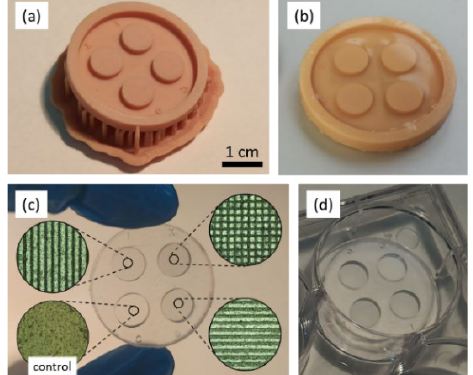
Fig. 1. Confocal images of a) unpatterned surface (control), b) and c) straight channels and d) matrix of square pillars micropatterned on the resin surface by PLA. The scale bar is the same in b), c) and